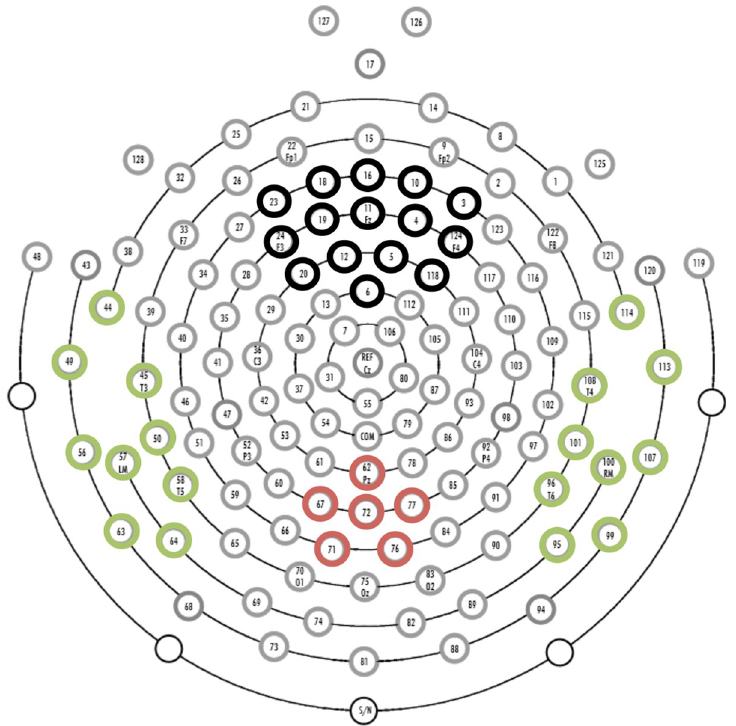
Fig 1. Selected electrodes in frontal (black), temporal (green), and parietal (red) areas.